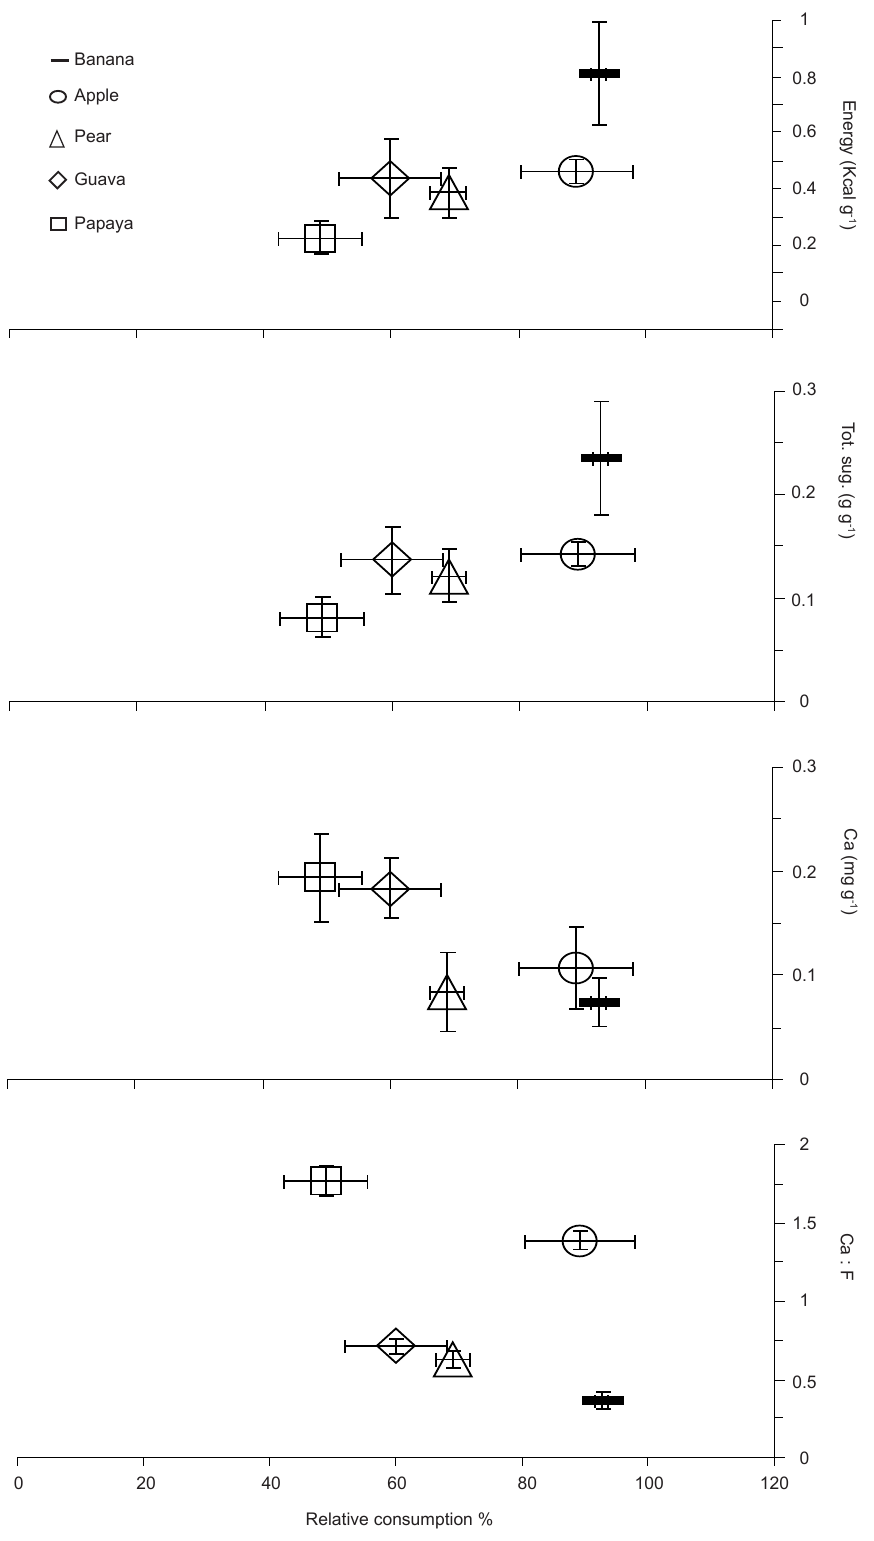
Figure 2. Nutritional values of fruit species versus the relative consumption by C. sphinx in captivity. Consumption of fruits shows the trend to correlate with both energy- and total sugar